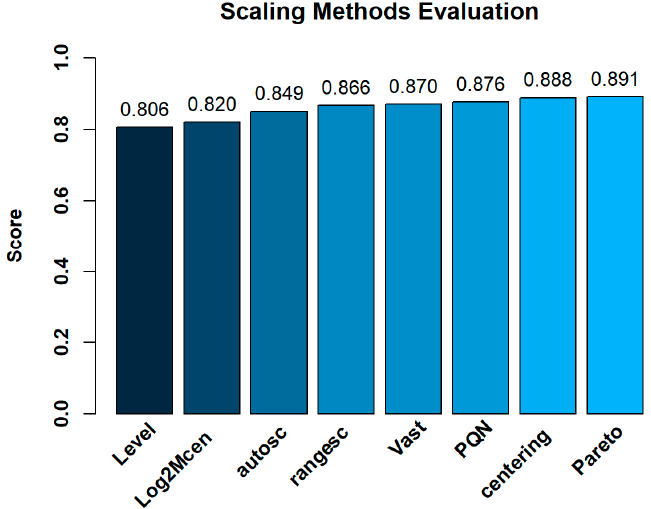
Figure 2. Scaling methods evaluation.